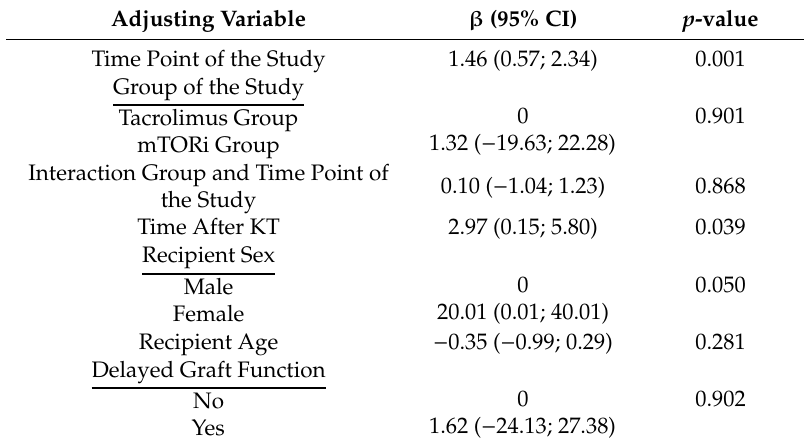
Table 2. Multivariable adjustment in the Generalized Estimating Equations (GEE) model for Treg cell numbers: The GEE population-averaged model analysis was also adjusted by time after KT, sex, age, and delayed graft function. Table shows the β and 95% confidence interval (CI) values and the p -value corresponding to each variable in the adjustment. Adjusting Variable β (95% CI) p -value Time Point of the Study 1.46 (0.57; 2.34)